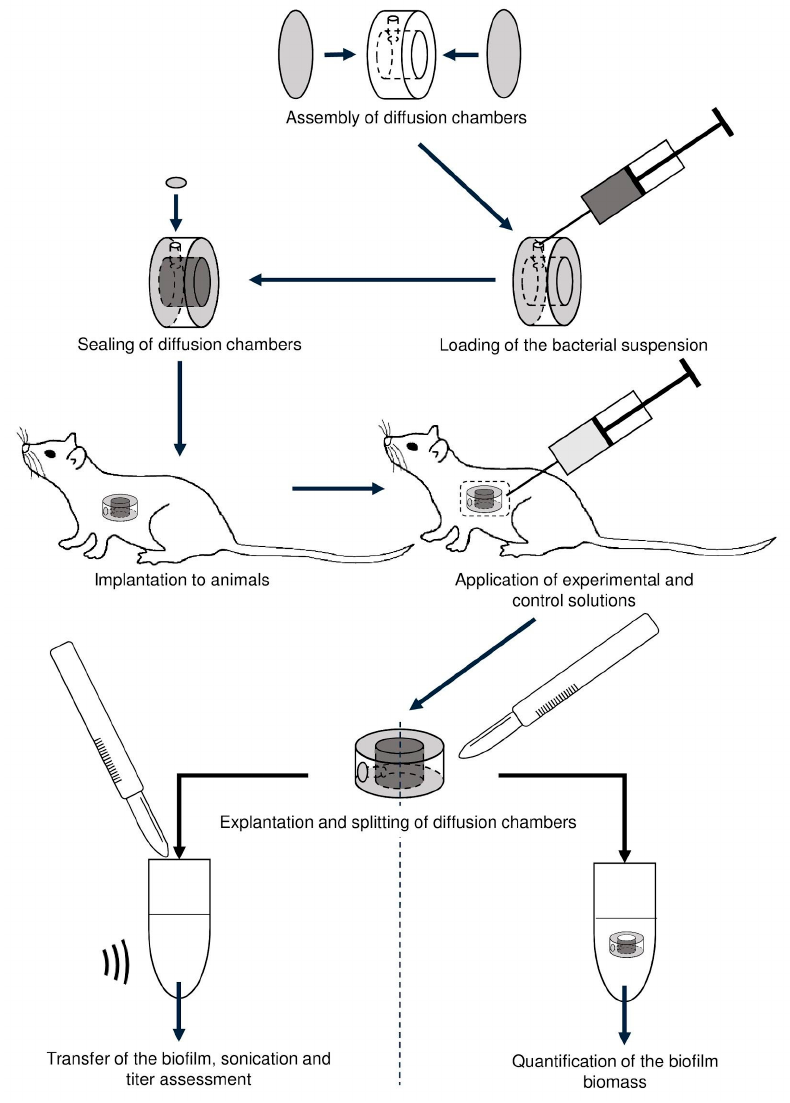
Figure 1. Experimental pipeline of the in vivo study.